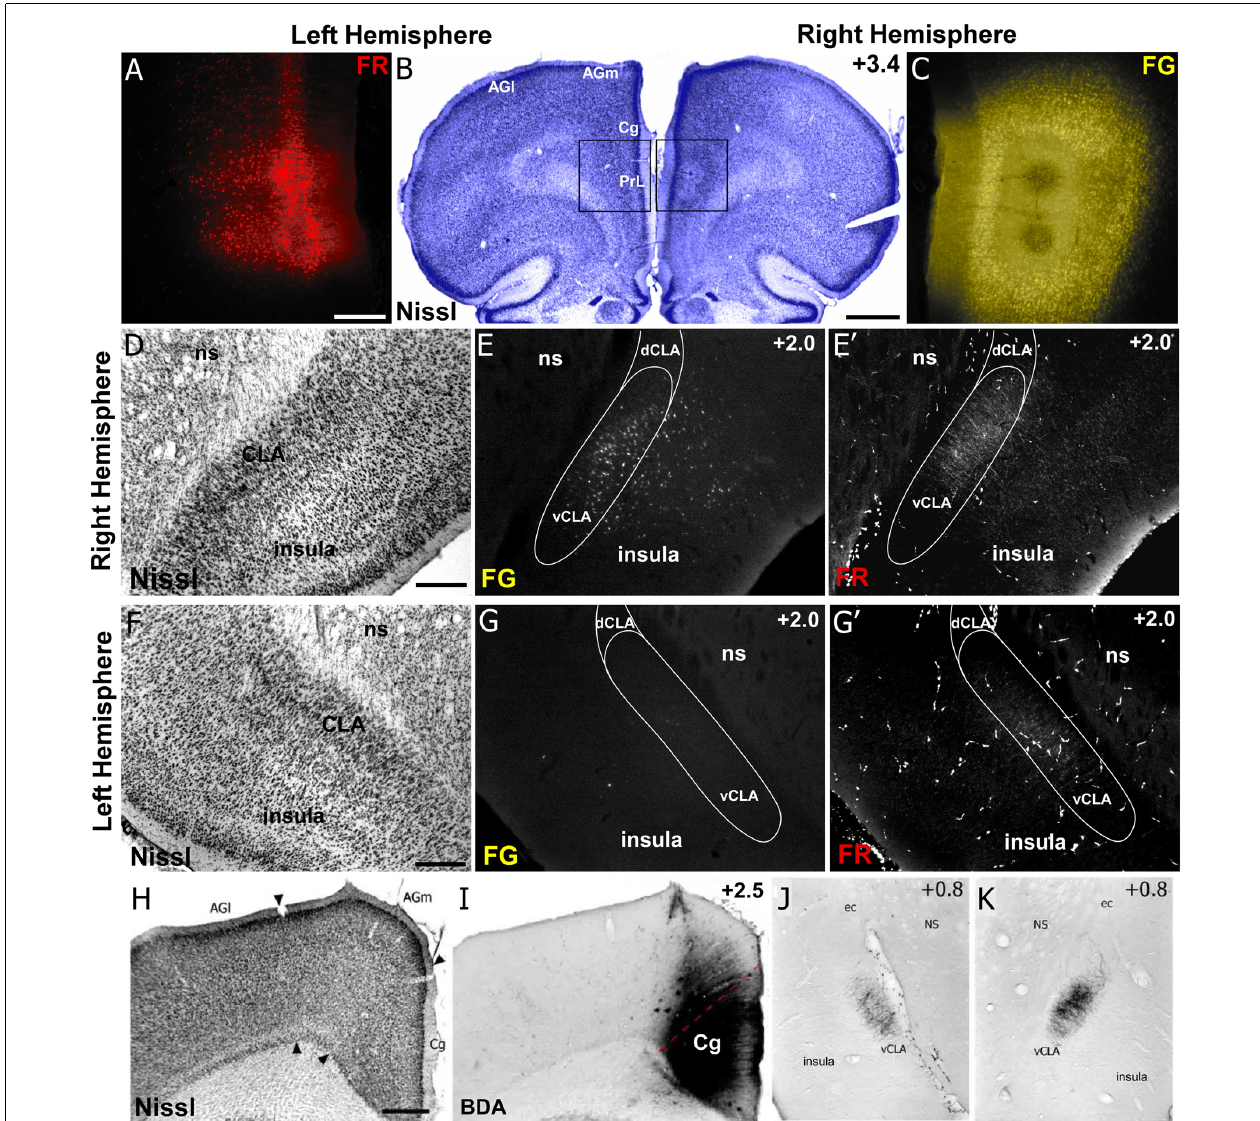
FIGURE 5 | Neuroanatomical tracing clarifies the structural connectivity between mPFC, Cg, CLA, and insula. (A–C) Anterograde tracer injection (Fluororuby, FR) in the left hemisphere, shown in panel (A) , and retrograde tracer injection (Fluorogold, FG) in the right hemisphere, shown in panel (C) , into prelimbic cortex (PrL) of a rat. Injection site locations shown in Nissl stained coronal section in panel (B) . (D–E (cid:48) ) In the right hemisphere, retrograde labeling (E) is visible in both CLA and insular cortex, whereas anterograde labeling (E (cid:48) ) was found only in CLA. Panel (D) shows location of CLA in Nissl stained coronal section. (F–G (cid:48) ) Labeling in the left hemisphere shows very little retrograde labeling in insula or CLA (G) , but some anterograde labeling in the claustrum (G (cid:48) ) . (H–K) Injection of anterograde tracer BDA in Cg cortex shows bilateral labeling in claustrum but no labeling in insula. Numbers in upper right corner of panels indicate distance from Bregma in millimeter. Scale bars: 250 µ m in (A) ; 1 mm in (B) ; 500 µ m in (D,F,H) ; Data modified with permission from Smith and Alloway (2014) and Smith et al. (2017). Abbreviations: AGl, agranular lateral cortex; AGm, agranular medial cortex; Cg, cingulate cortex; PrL, prelimbic cortex; dCLA, dorsal claustrum; vCLA, ventral claustrum; ns, neostriatum; ec, external